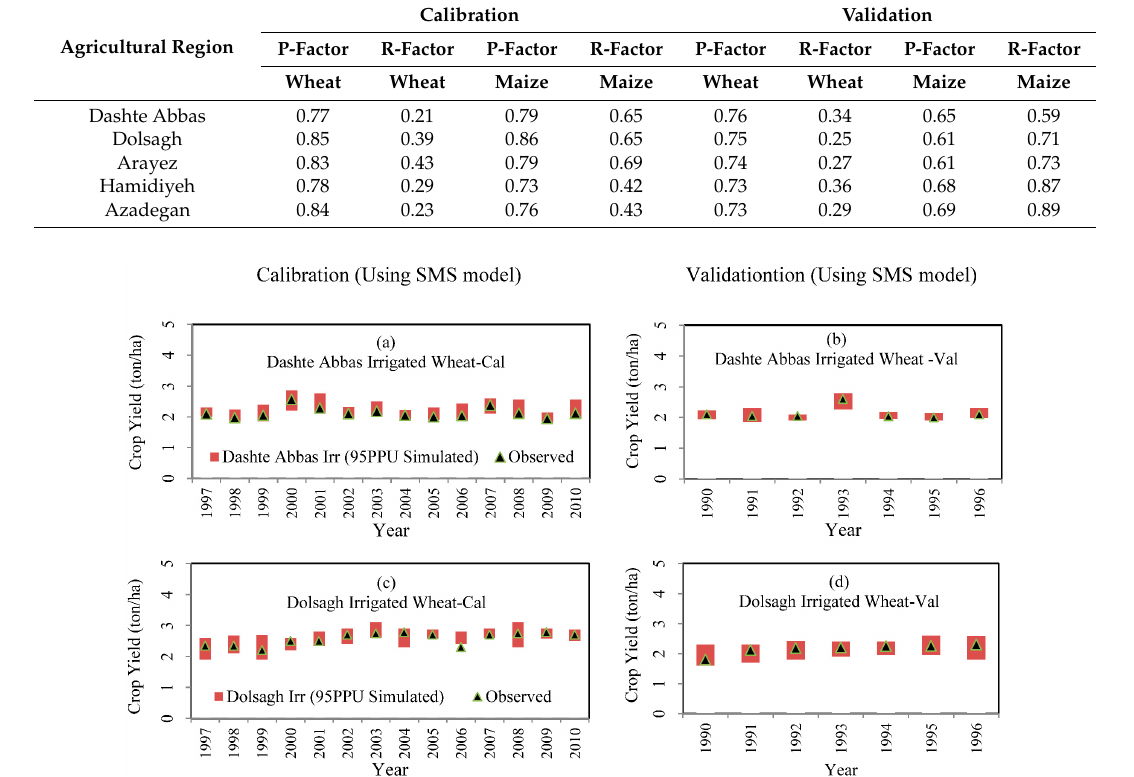
Table 3. Calibration (1997–2010) and validation (1990–1996) results of the coupled SWAT-MODSIM model for irrigated wheat and maize using the SMS model in LKRB.